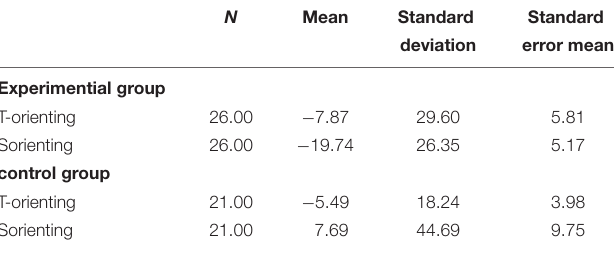
TABLE 3 | Reaction bias scores on height-related words in experiment group and control